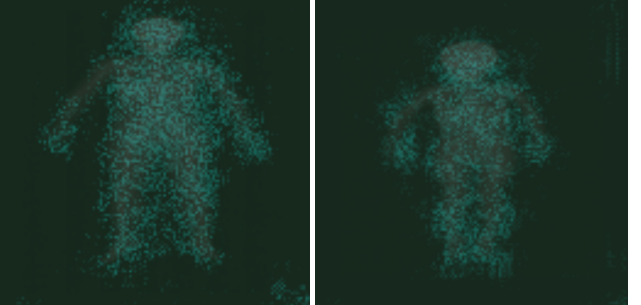
Figure 8. The results of the vanilla gradient algorithm were placed on top of the original image, and its colour was changed to